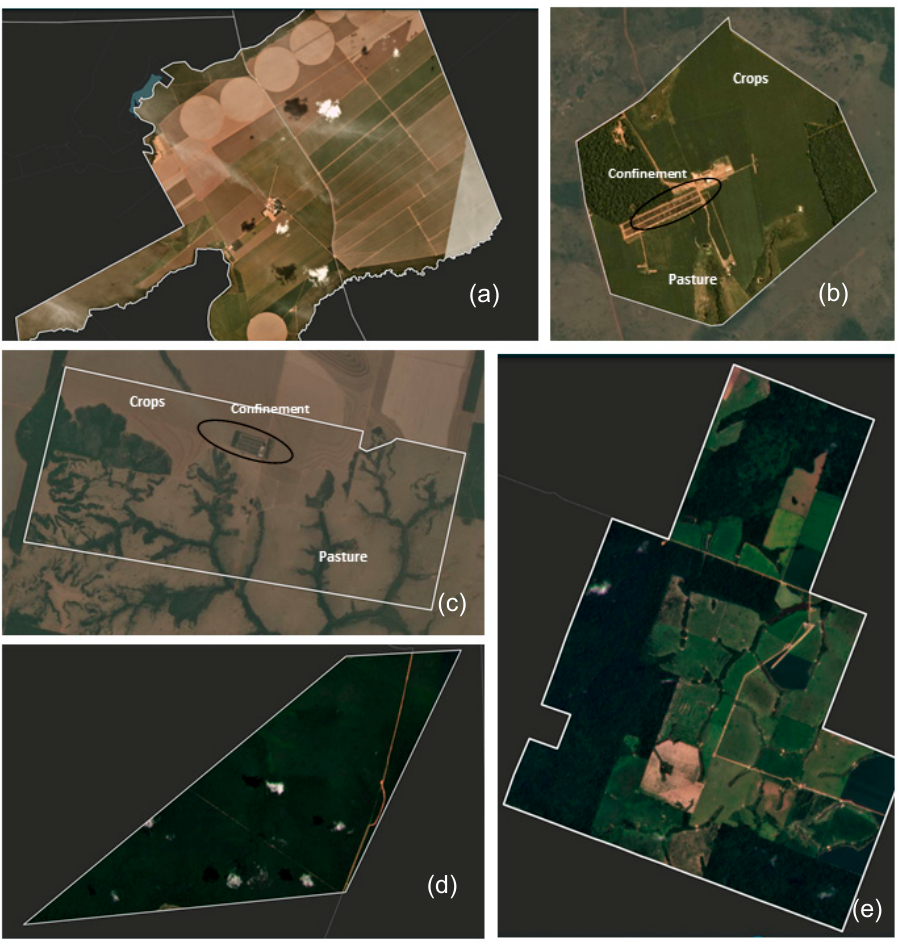
Figure 5. Cattle production systems on high-volume suppliers classified based on satellite imagery. ( a ) Integrated Crop-livestock System (ICLS); ( b , c ) Mixed System-ICLS and structure for cattle confinement; ( d ) Not cattle productive system; ( e ) Extensive system.